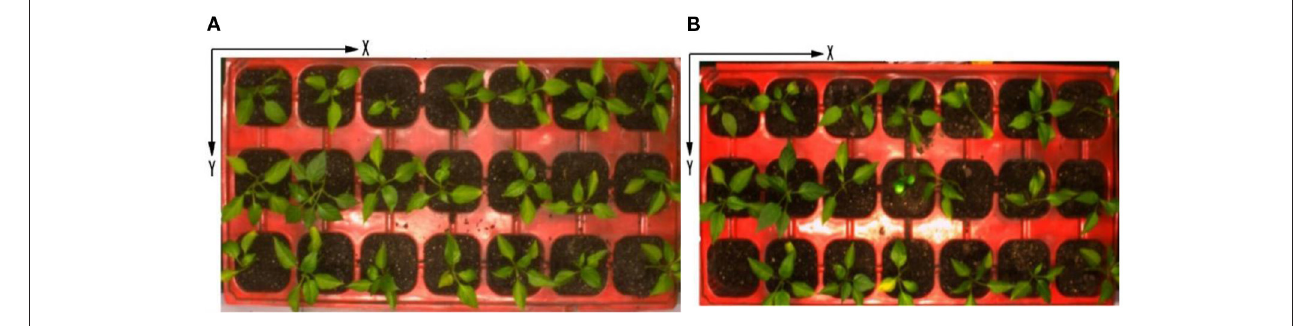
FIGURE 4 | Original image of pepper seedlings.